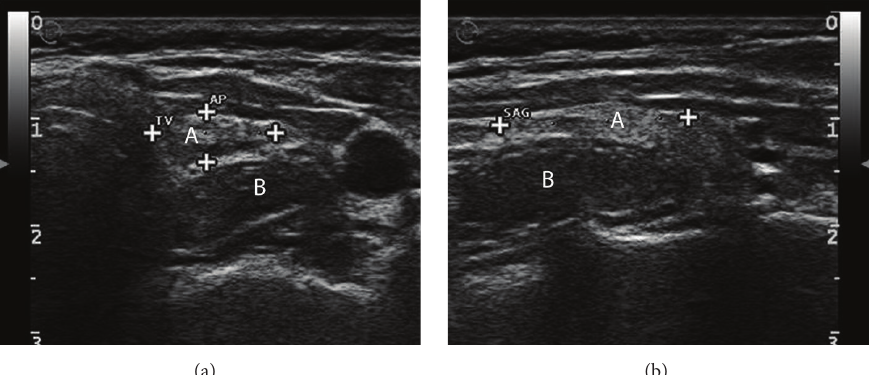
Figure 1: A: transverse (a) and longitudinal (b) ultrasound scans of the left thyroid lobe. B: transverse (a) and longitudinal (b) ultrasound scans of the esophageal lesion outside the posterior pole of the left thyroid lobe.